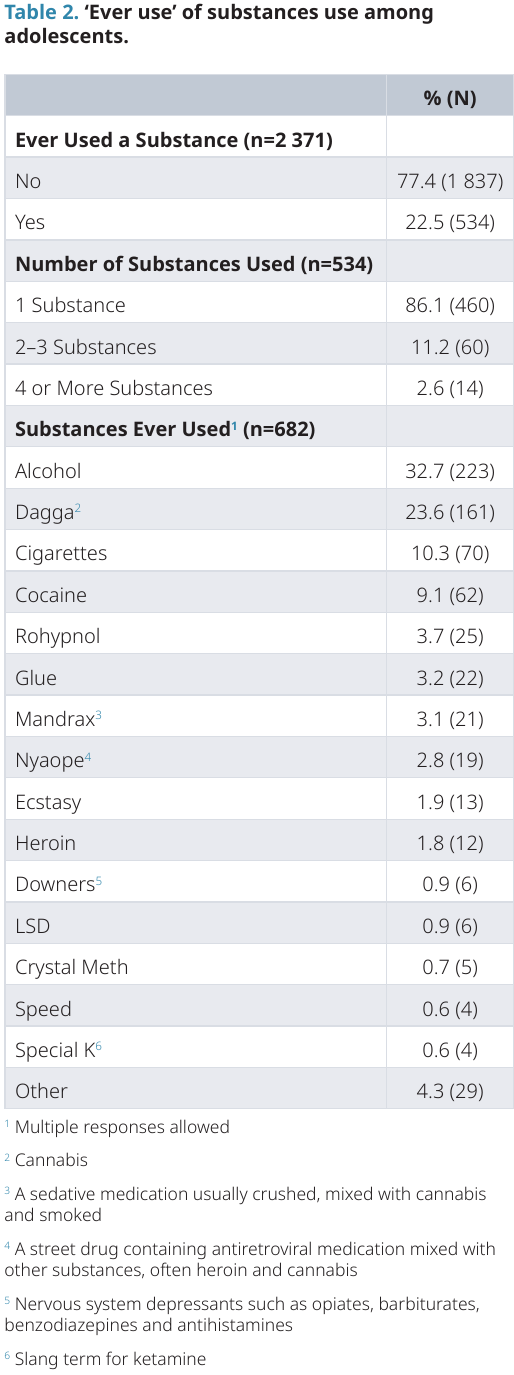
Table 2. ‘Ever use’ of substances use among